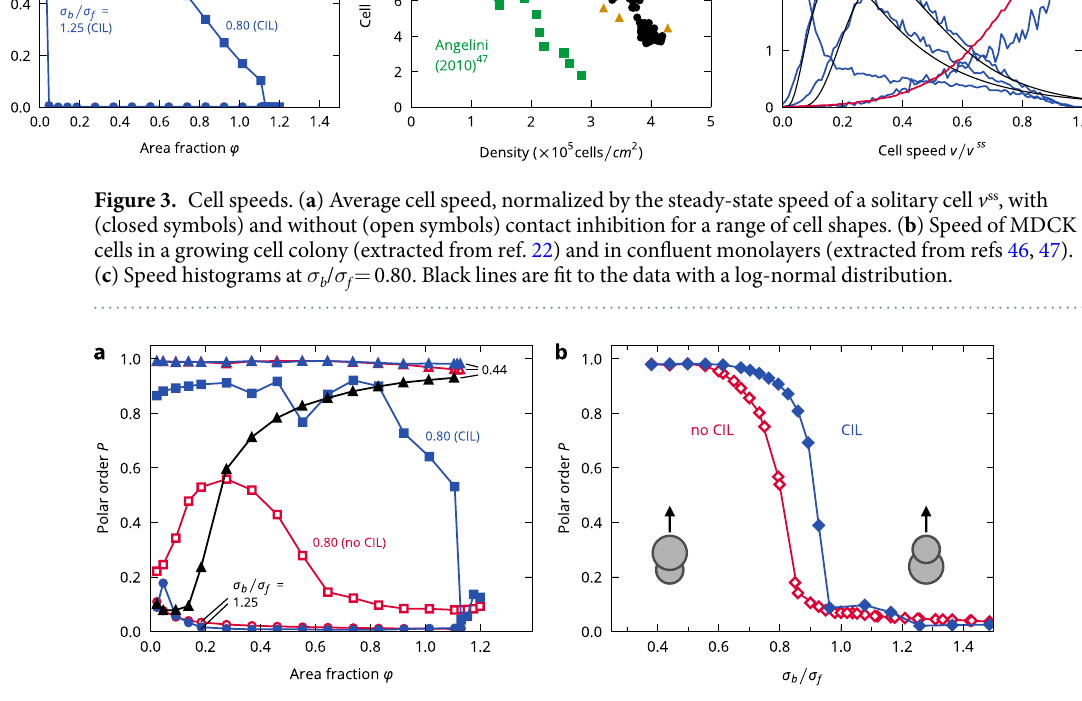
Figure 4. Collective alignment. ( a ) Polar order p as a function of area fraction for a range of cell shapes. Simulations with cell noise at σ b / σ f = 0.44 are shown in black. ( b ) Polar order p as a function of cell shape at area fraction ϕ ≈